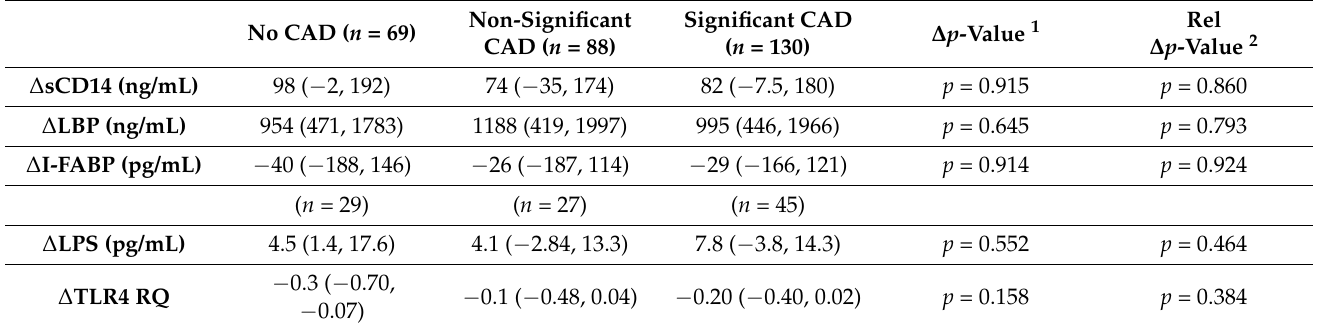
Table 4. Changes (delta values) in gut leakage markers according to coronary artery